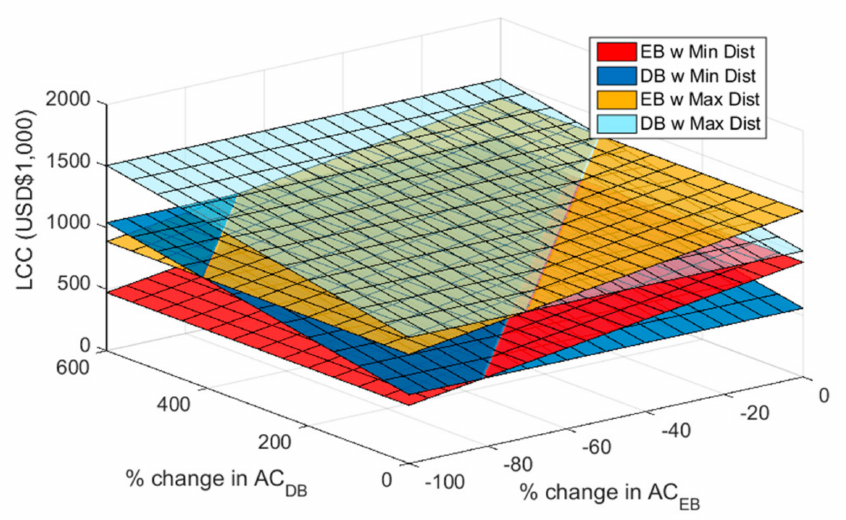
Figure 6. Relationship between the LCCs of electric and diesel buses, with different percentage changes in their acquisition